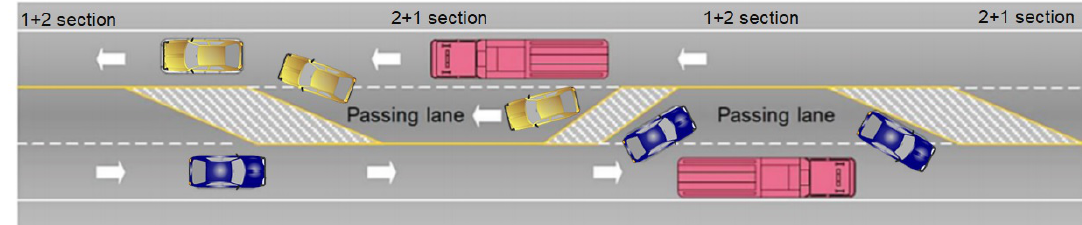
Figure 1. Example of 2+1 road section in a two-way interurban road with only one carriageway.